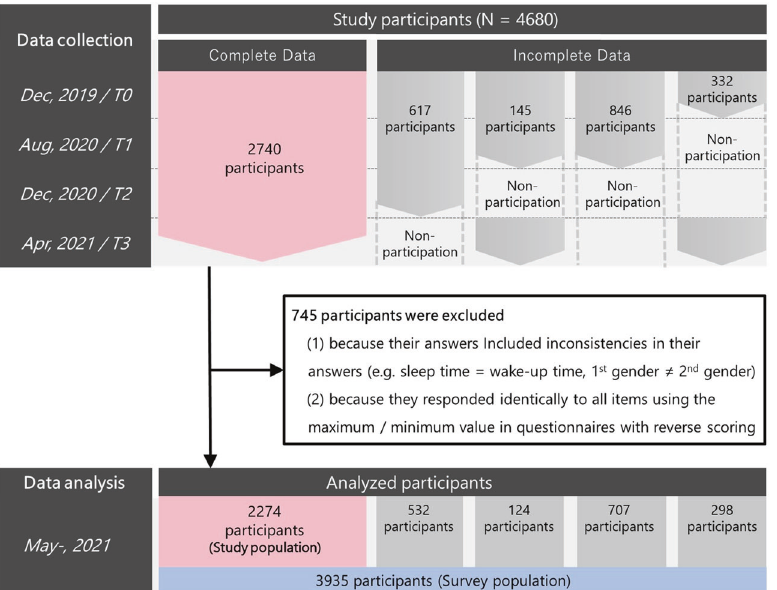
Fig. 1 Selection into cohorts. 4680 participants participated in the T0 survey immediately before and during the COVID-19 pandemic. 745 participants were excluded due to data problems and 3935 participants remained in the analysis and were de fi ned as the “ survey population. ” Of the 3935, 1661 participated in only two or three surveys (incomplete data) (532, T0-T2; 124, T0-T1, T3; 707, T0-T1; 298, T0 and T3). Therefore, 2274 respondents completed all four surveys and were de fi ned as the “ study population ”